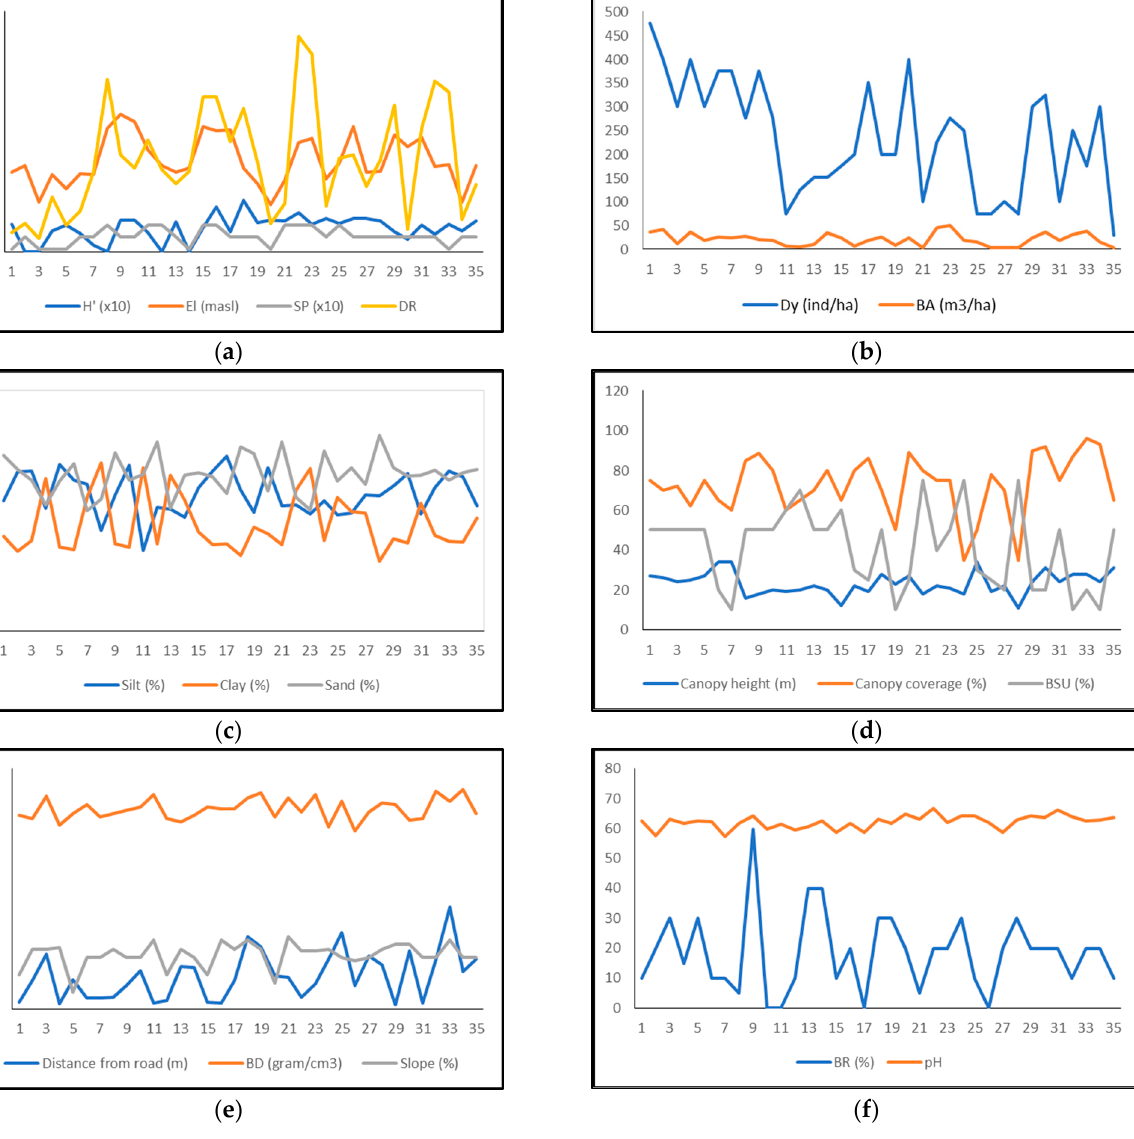
Figure A1. Relationship graphs of vegetation characteristics and associated factors within PCA components ( a ) = component 1, ( b ) = component 2, ( c ) = component 3, ( d ) = component 4, ( e ) = component 5 and ( f ) = component 6.